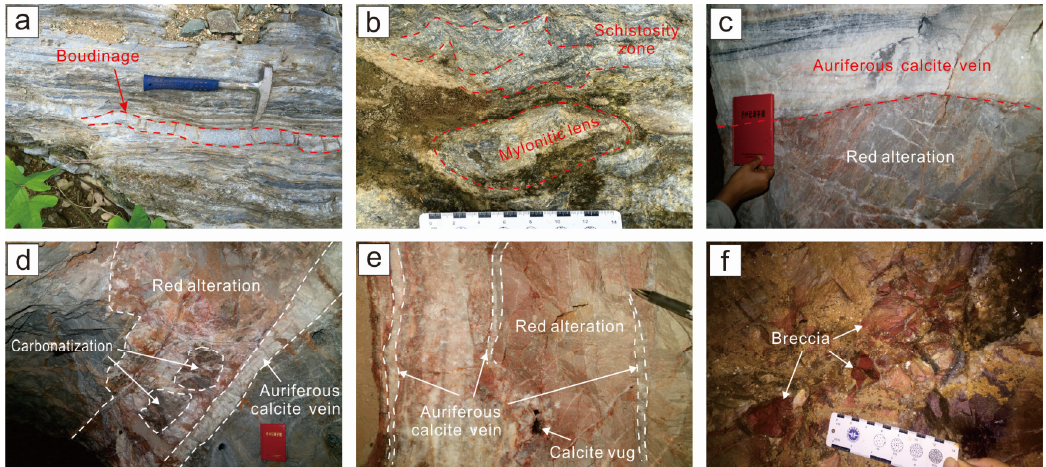
Figure 3. Typical outcrops of deformation, alteration and mineralization in Phapon gold deposit. ( a ) Boudinage deformation found in limestone; ( b ) schistosity zones and mylonitic lens near the thrust plane; ( c ) auriferous calcite vein and surrounding red alteration zone; ( d ) carbonation clumps locally present in the red alteration zone; ( e ) calcite veins branched and intercalated into the red alteration zone; ( f ) breccia of red altered rock.